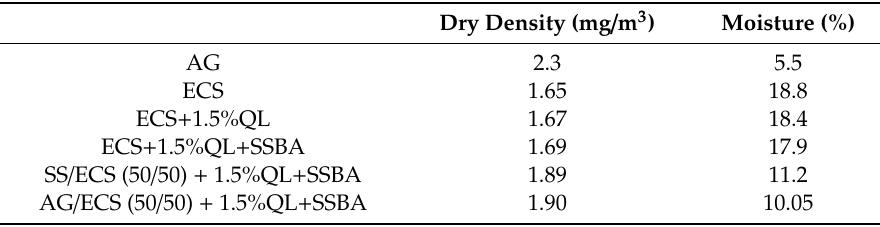
Table 4. Dry density and optimum moisture results.